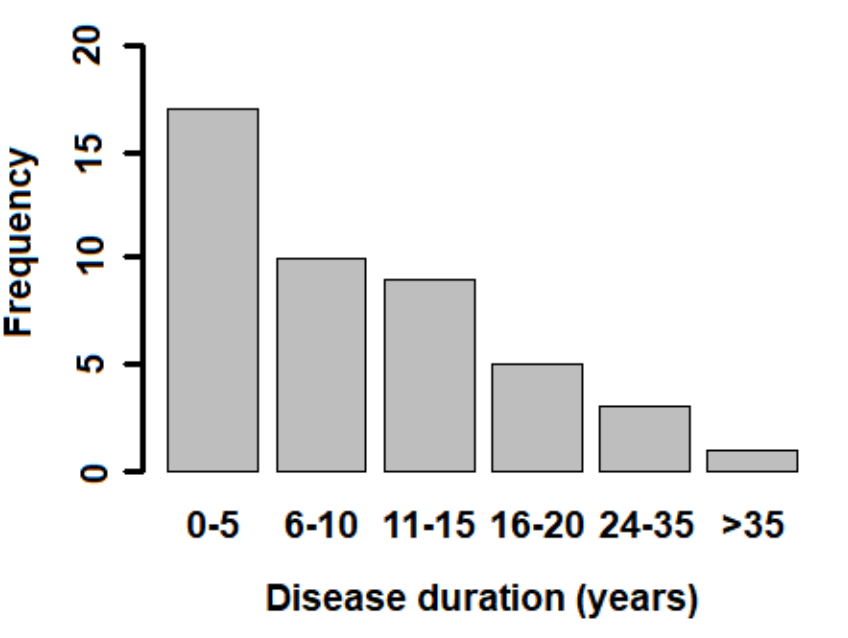
Figure 1. Distribution of disease onset time for MS patients.